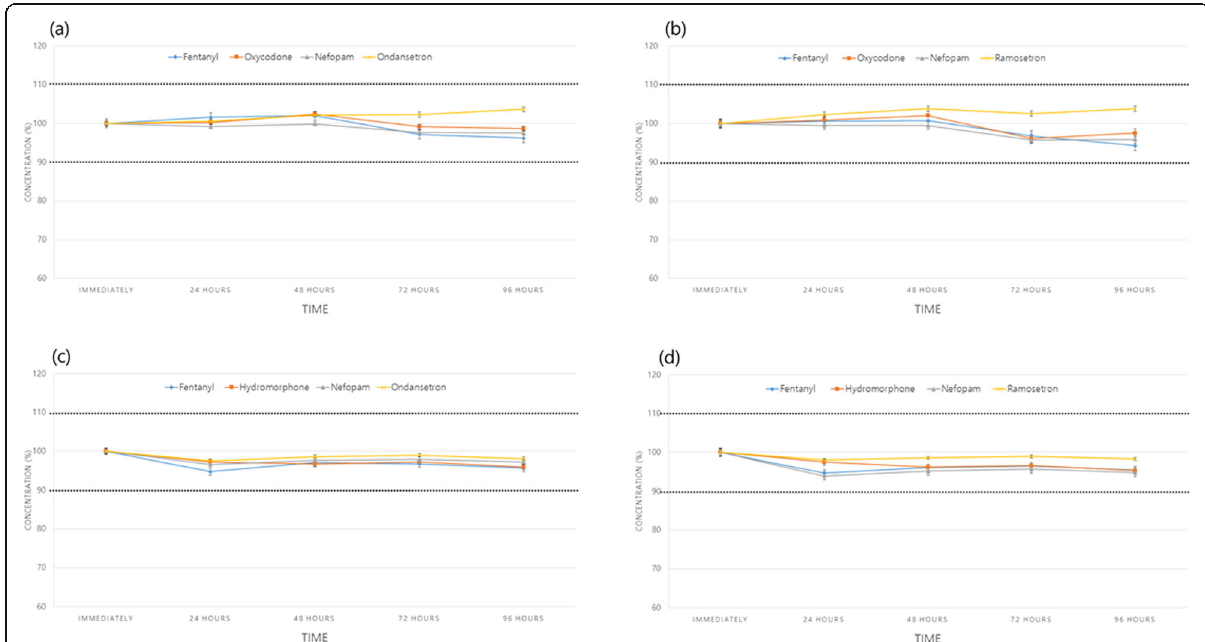
Fig. 2 Changes in the concentration of drugs in B mixtures over time. The concentration measured immediately after mixture preparation was taken to be 100%. a Mixture 1B. b Mixture 2B. c Mixture 3B. d Mixture